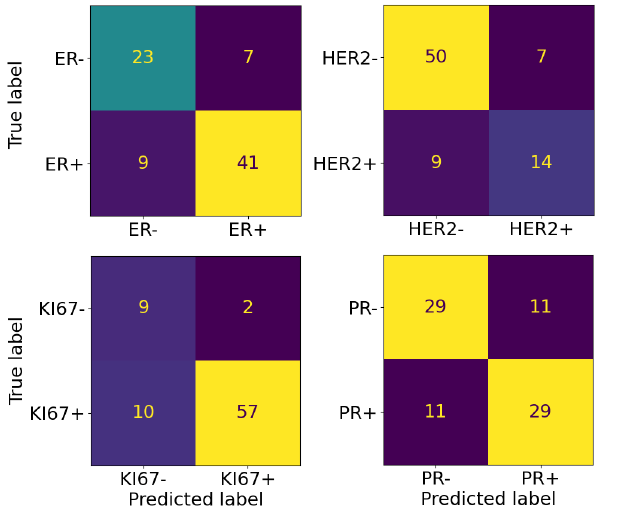
Figure 4. Confusion matrix for the four markers at the end of the two-step pipeline. The final feature number was obtained in the LOOCV step, and the list of the extracted features list is available in Table 7. For HER2, the best results were obtained with a combination of features coming from two different image modalities (i.e., ADC, T2). For the Ki67 and PR markers, the features all belong to the PC modality, whereas for the ER marker, they belong to the T2 one. Table 6. Results for the four markers in terms of other metrics: acc = accuracy; prec = precision; and rec =